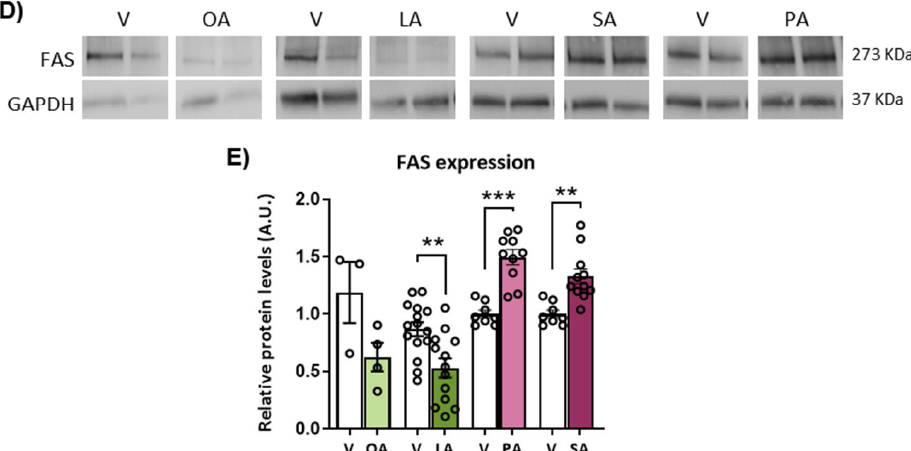
Figure 5. Effects of intracerebroventricular (ICV) administration of oleic acid, linoleic acid, palmitic acid and stearic acid on hypothalamic expression of ACC, AMPK and FAS in WT mice. ( A ) Representative blots of pACC, ACC, pAMPK and AMPK protein levels and ( B , C ) quantification of the pACC/ACC and pAMPK/AMPK ratios in the hypothalamus of mice after 48 h of ICV administration of fatty acids. ( D ) Representative blots and ( E ) quantification of FAS protein levels in the hypothalamus of mice after 48 h of ICV administration of fatty acids. Data are represented as mean ± SEM (3 blots from 5–7 different mice per group). * p < 0.05, ** p < 0.01, *** p < 0.001 vs. vehicle. FAS: Fatty acid synthase. OA: oleic acid; LA: linoleic acid; PA: palmitic acid; SA: stearic acid; V: vehicle.